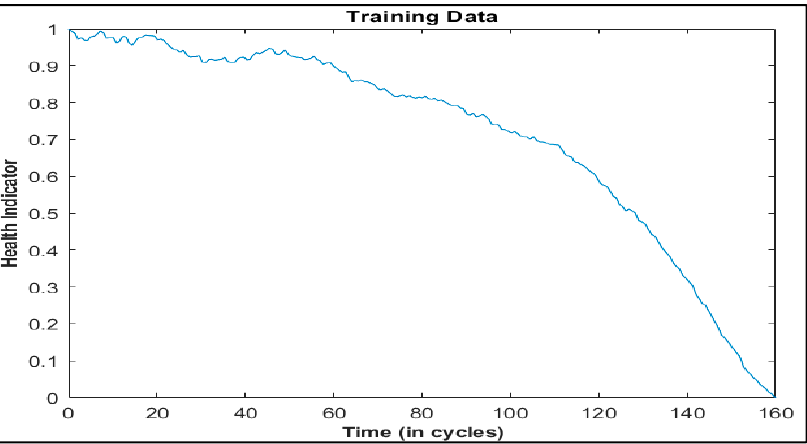
Figure 6. Fused health indicator for training data.